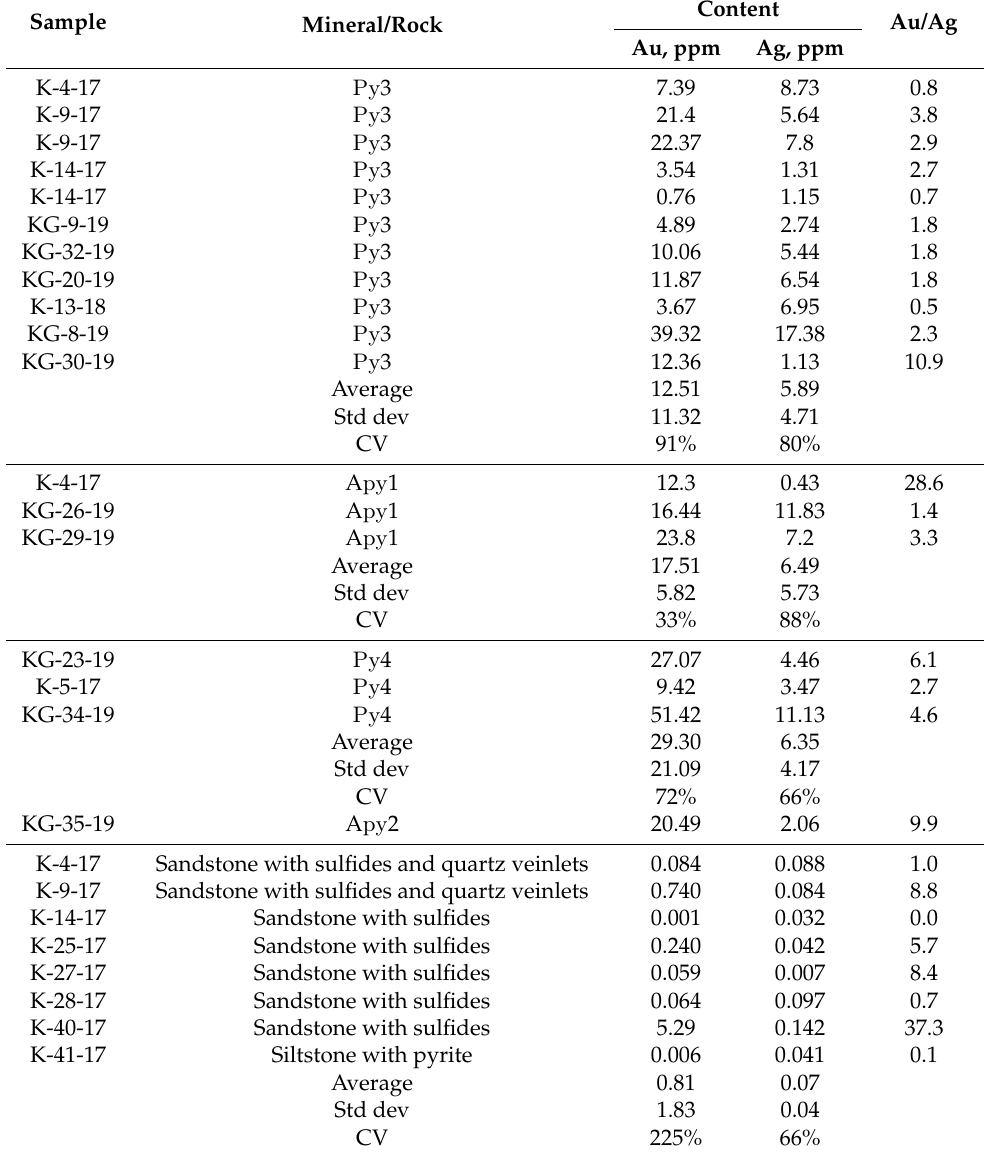
Table 3. Results of atomic absorption analysis of proximal metasomatites, their sulfides, and sulfides in quartz veins.